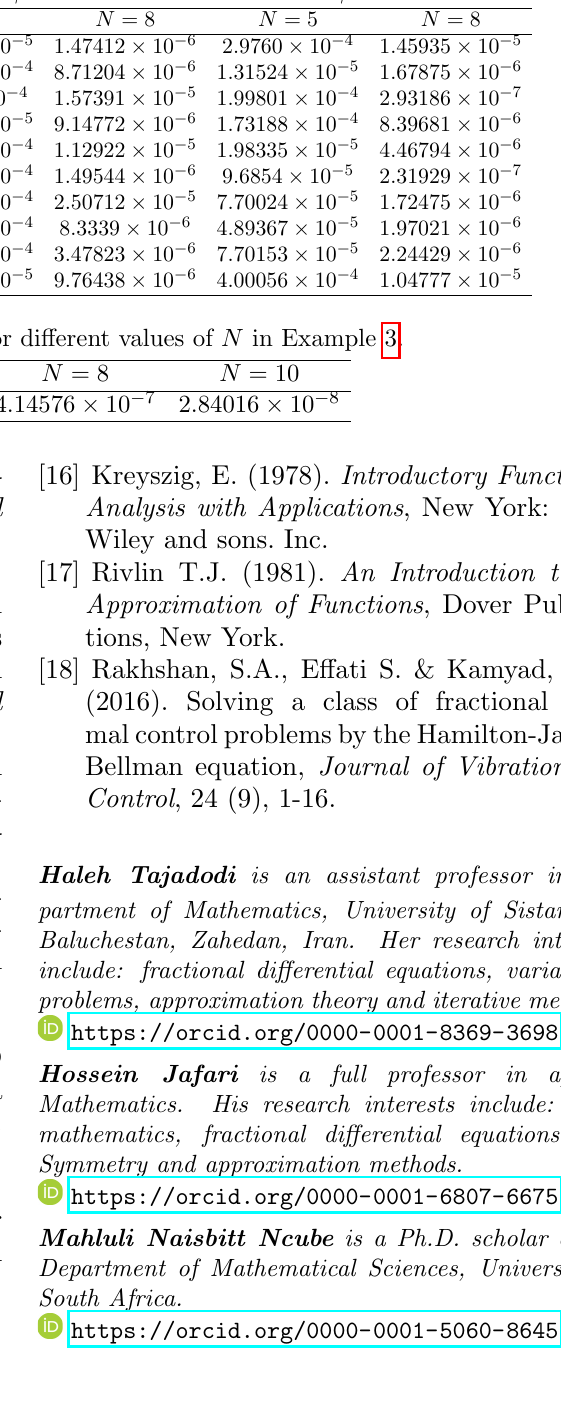
Table 5. Absolute errors of J at N = 5 for different values of γ in Example 3. γ = 0 . 5